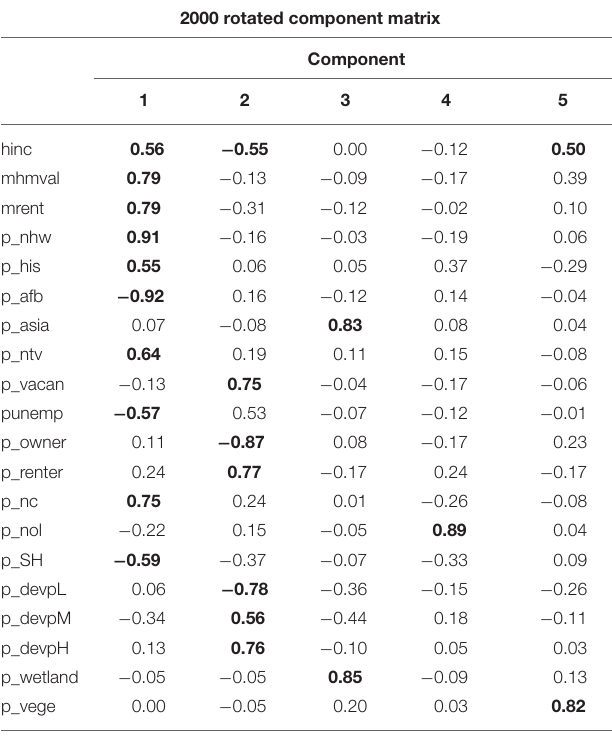
TABLE 6 | Results of principal component analysis using data from year 2000. 2000 rotated component